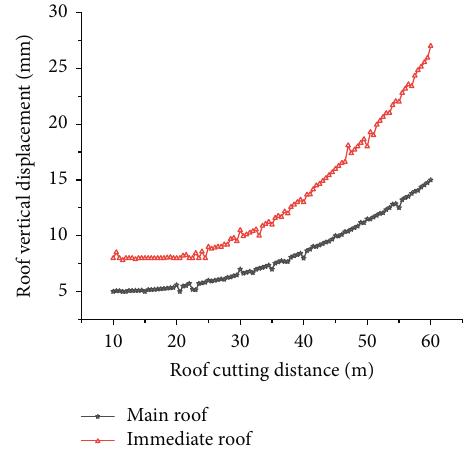
Figure 10: Relationship between roof cutting distance and roof displacement in roof cutting